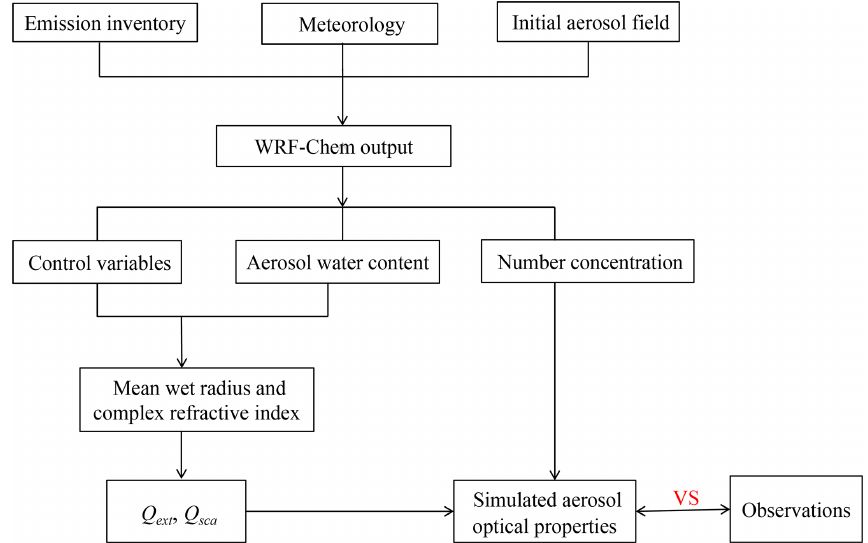
Figure 2. Diagram describing the forward observation operator used to transform aerosol mass concentrations to optical parameters. Q ext and Q sca are extinction and scattering efficiencies, respectively, which are functions of the size parameter and complex refractive